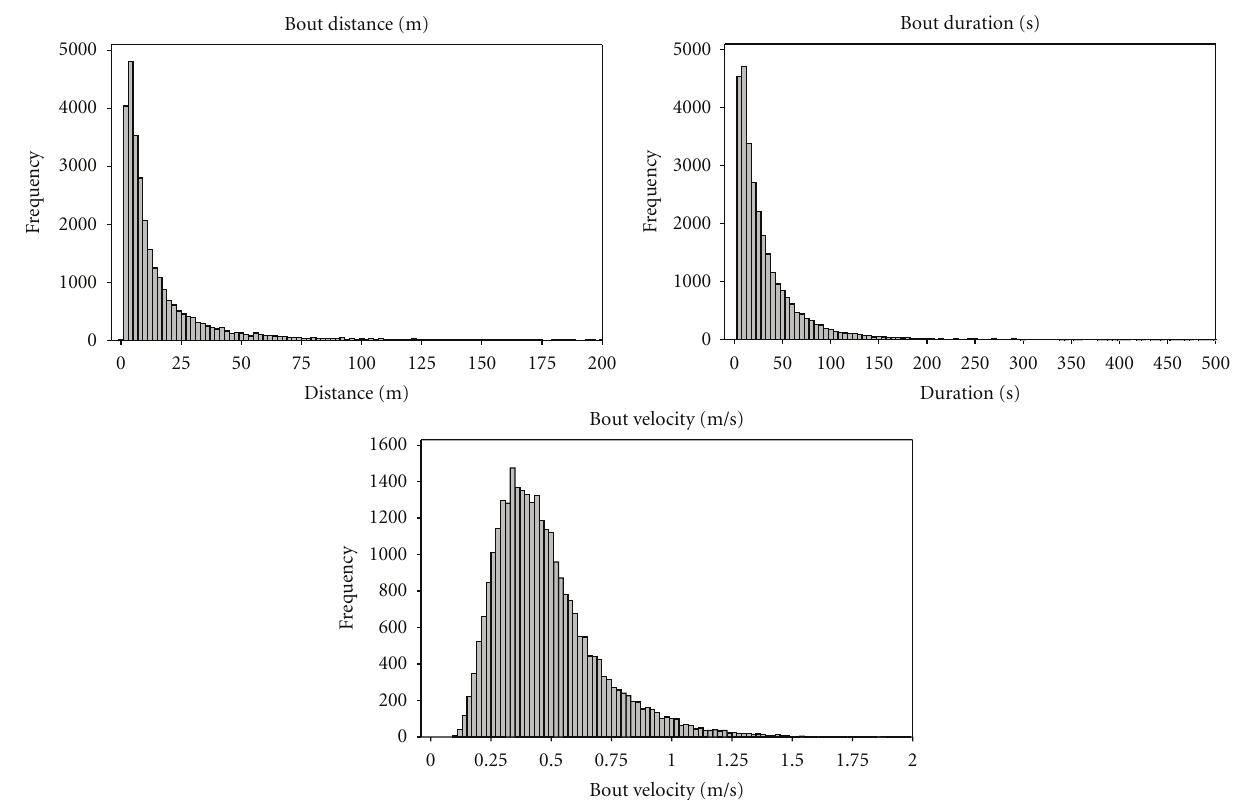
Figure 2: Histograms of typical bout parameters: distance, duration, and velocity.